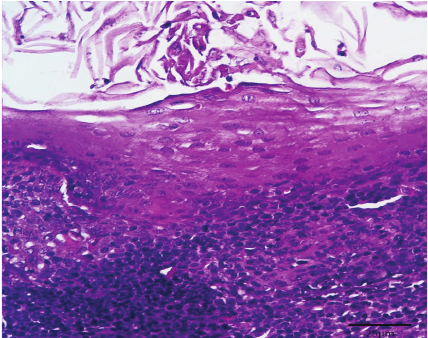
Figure 3: Detail showing the largest increase in fibrous capsule and a dense lymphocytic infiltrate (HE ×